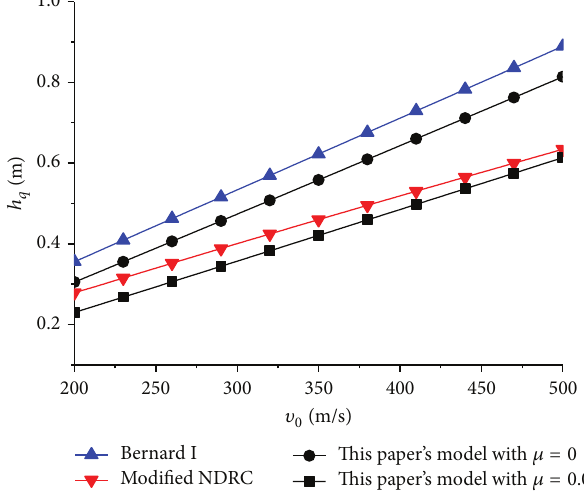
Figure 11: The predicted results for T-3 and P-1.